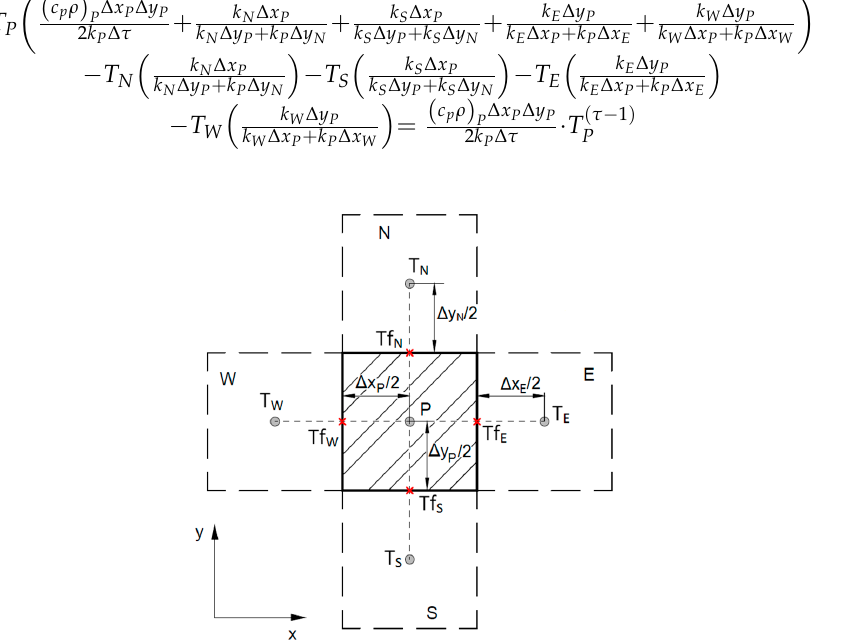
Figure 3. Discretization of the thermal field.